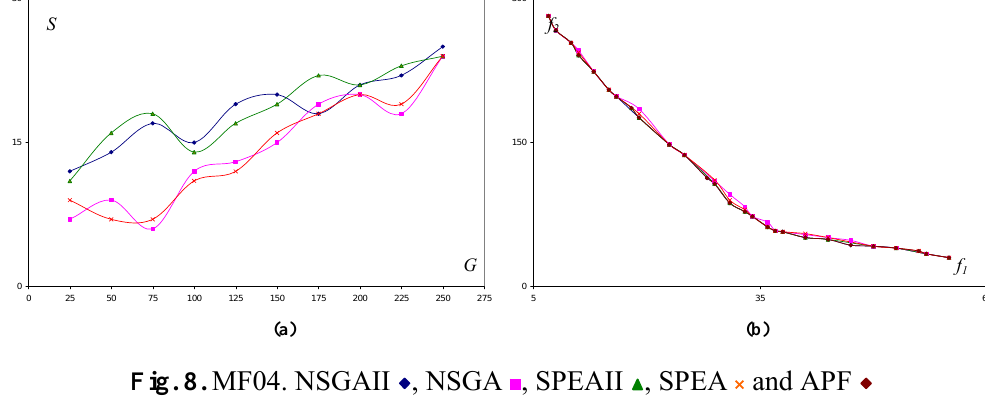
Fig. 8. MF04. NSGAII , NSGA , SPEAII , SPEA and APF